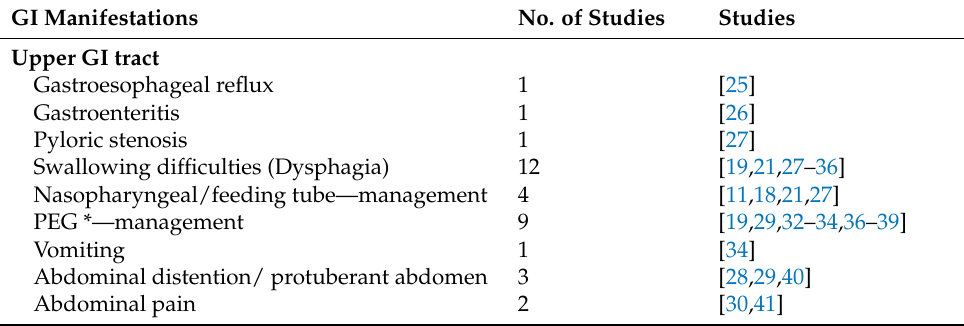
Table 4. GI manifestations in MPS III reported in the